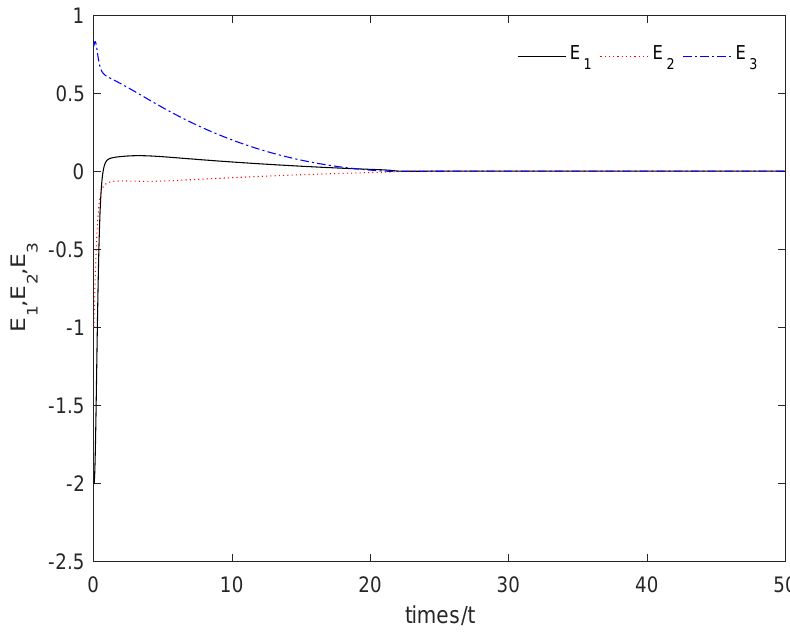
Figure 5. The sum system (21) is asymptotically stable.